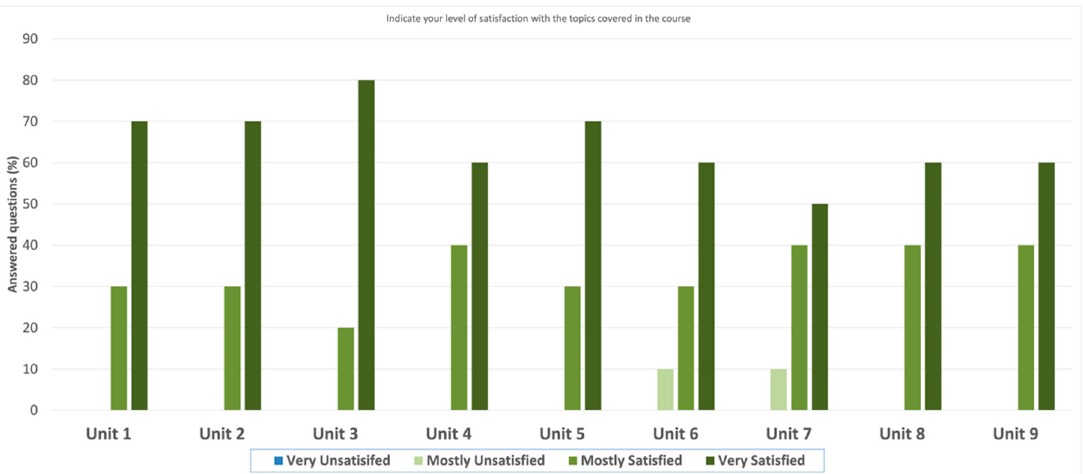
Figure 5. Participant’s answers to Question #4—“Indicate your level of satisfaction with the topics covered in the course”.